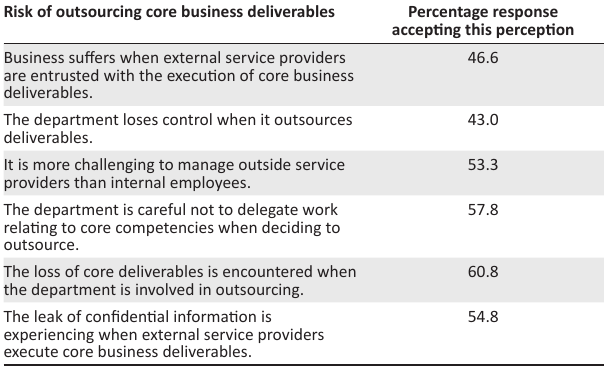
TABLE 6: Risk of outsourcing core business deliverables.